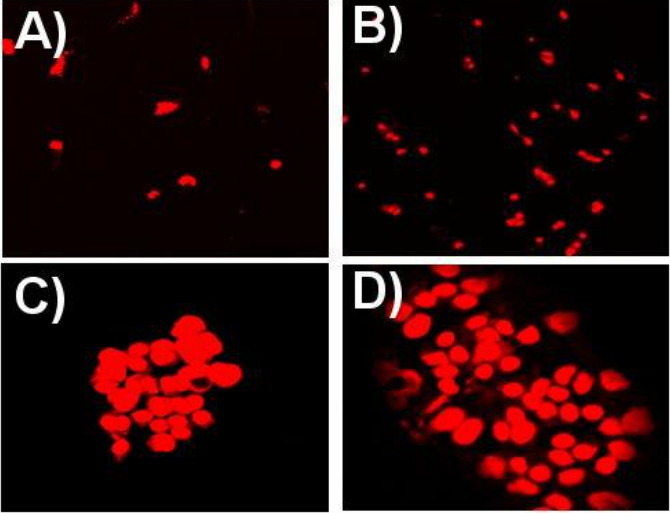
Figure 2. Representative figures of melanocytes treated with  -MSH. Cells were observed by a confocal microscope after PI staining. Micrographs’ showing dead cells at different incubation time (a) 24 h,  200; (b) 48 h,  200; (c) 72 h,  400; (d) 96 h,  400,